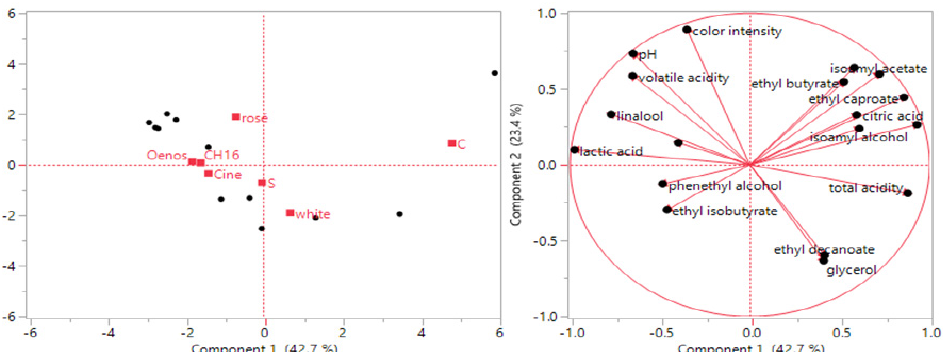
Figure 1. Principal component analysis of 14 metabolites of Moschofilero rosé and white wines fermented under different malolactic fermentation schemes. The O. oeni strains used to drive the malolactic fermentation were Viniflora ® CH16 (CH16), Viniflora ® Oenos (Oenos) and Viniflora ® CiNe (Cine). Spontaneous fermentation is denoted by (S) and wines in which no MLF took place are denoted by (C).